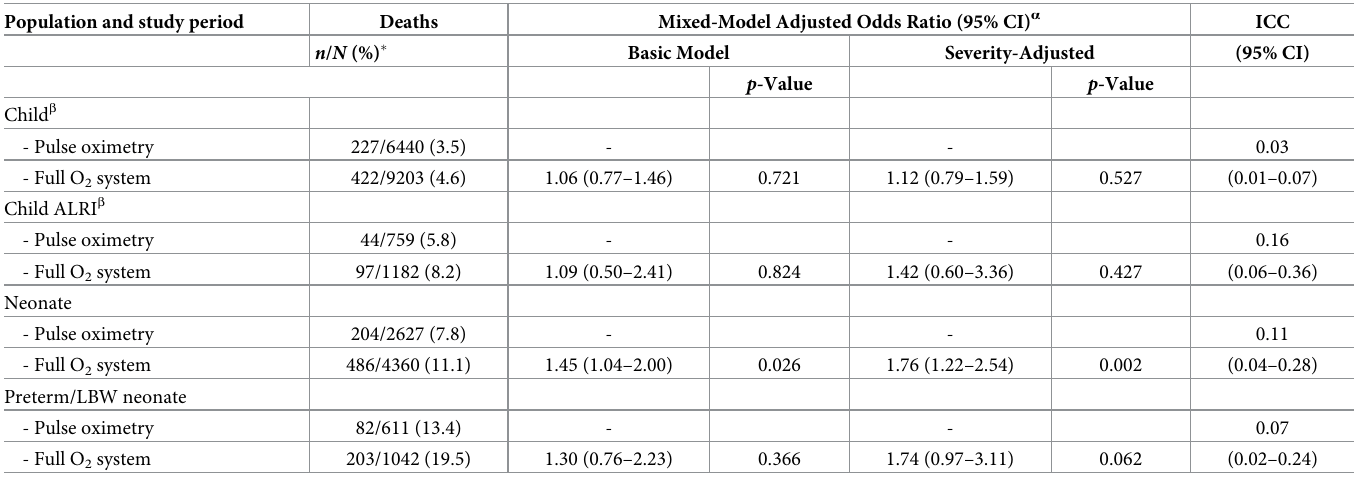
Table 2. Effect of the full oxygen system intervention on mortality—Primary outcome analysis comparing the full oxygen system intervention to the prior standard of care plus pulse oximetry. Population and study